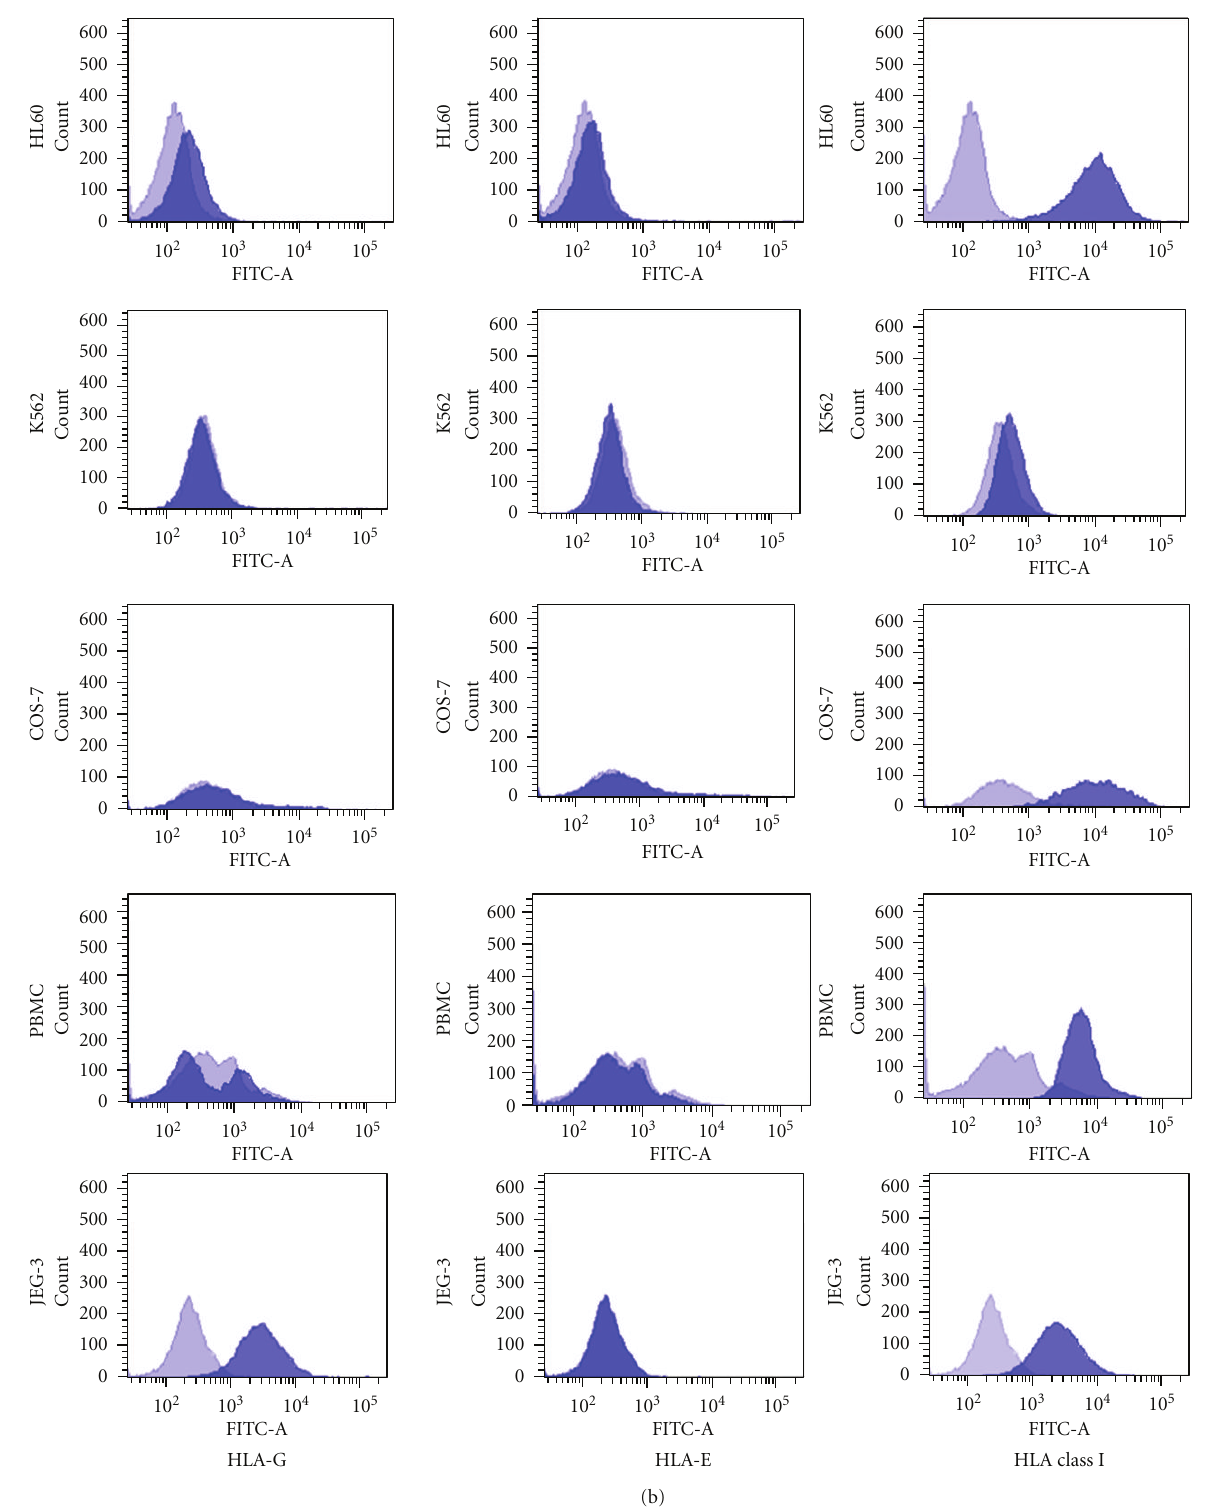
Figure 3: HLA expression. (a). Representative flow cytometric gating strategy for analysis of HLA expression on all used cell lines (shown for RPMI8226). All cells were stained with anti-HLA-I/-E/-G IgG1, followed by secondary goat anti-mouse IgG1 FITC. (b). HLA class I molecules were detectable on all cell lines except for negative control K562. JEG-3 were strongly positive for HLA-6, while detection on NK92 and HL60 was marginal. HLA-E as the ligand for NK62A lacked on all cell linesexcept on minor staining on